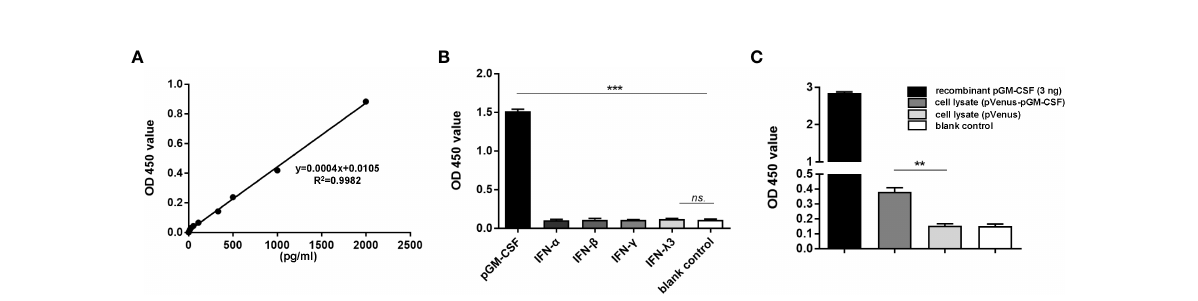
FIGURE 1 Evaluation of speci fi city and repeatability for pGM-CSF double antibody sandwich ELISA. (A) The standard curve was generated by using recombinant pGM-CSF protein at the indicated concentrations, the formula and correlation coef fi cient were shown as well. (B) Evaluation of the assay speci fi city of pGM-CSF ELISA. Recombinant pGM-CSF along with IFN- a , IFN- b , IFN- g , and IFN- l 3 at the concentration of 3ng/ml was used for pGM-CSF double antibody sandwich ELISA to evaluate the speci fi city the assay. (C) Evaluation of the pGM-CSF ELISA reactivity with mammalian expressed pGM-CSF. HEK-293T cells transfected with VenusC1-pGM-CSF or empty vector for 24 hours, then cells were lyzed using NP40 buffer and added as ELISA sample for pGM-CSF detection, and recombinant pGM-CSF protein (3ng) was included as positive